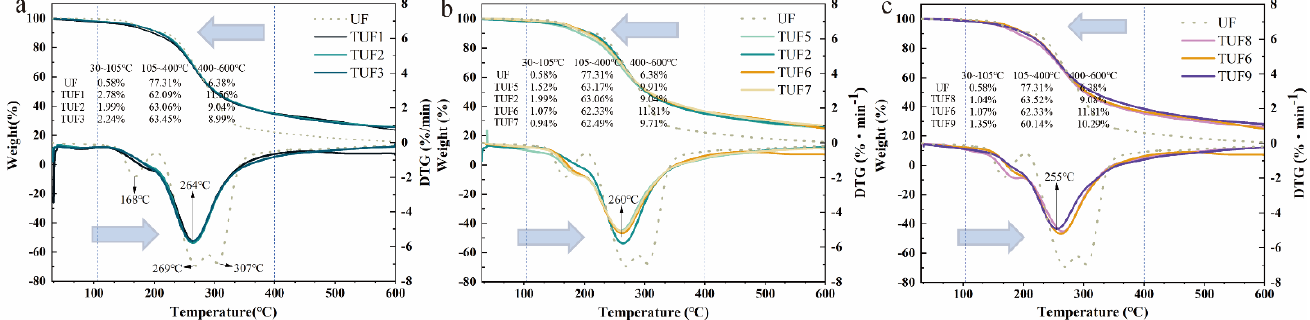
Figure 5. TG and DTG thermograms of UF and TUF resins prepared under varied reaction conditions. ( a ) reaction temperature; ( b ) reaction times; ( c ) tannin addition.